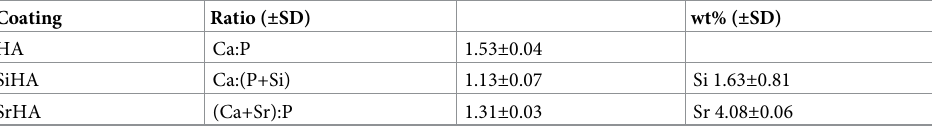
Table 2. Elemental analysis of coatings with the appropriate Ca:P ratio and wt% of substituted element shown.